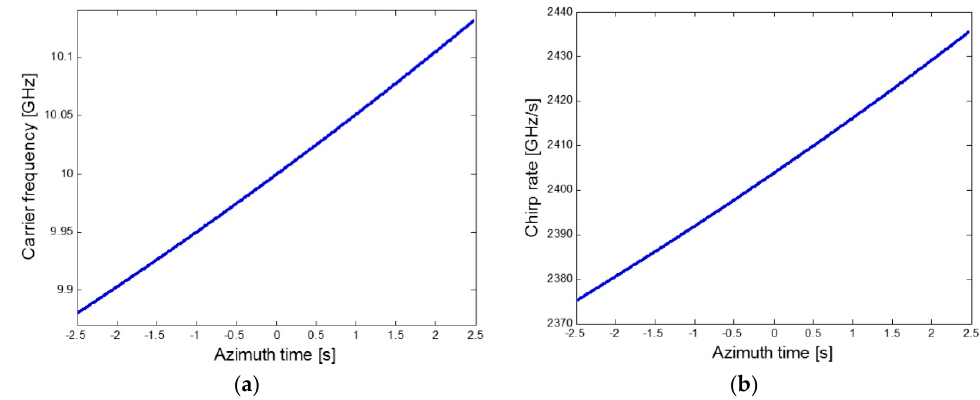
Figure 11. Azimuth dependent: ( a ) carrier frequency; and ( b ) chirp rate when the new parameter adjusting technique is employed.